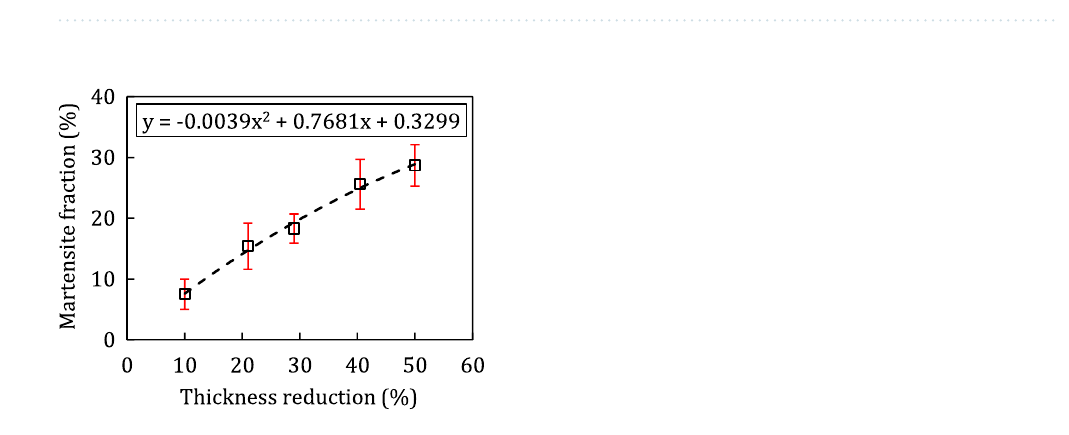
Figure 3. Change in the martensite fraction as finction of thickness reduction in cold rollign process for initrially annealed 316